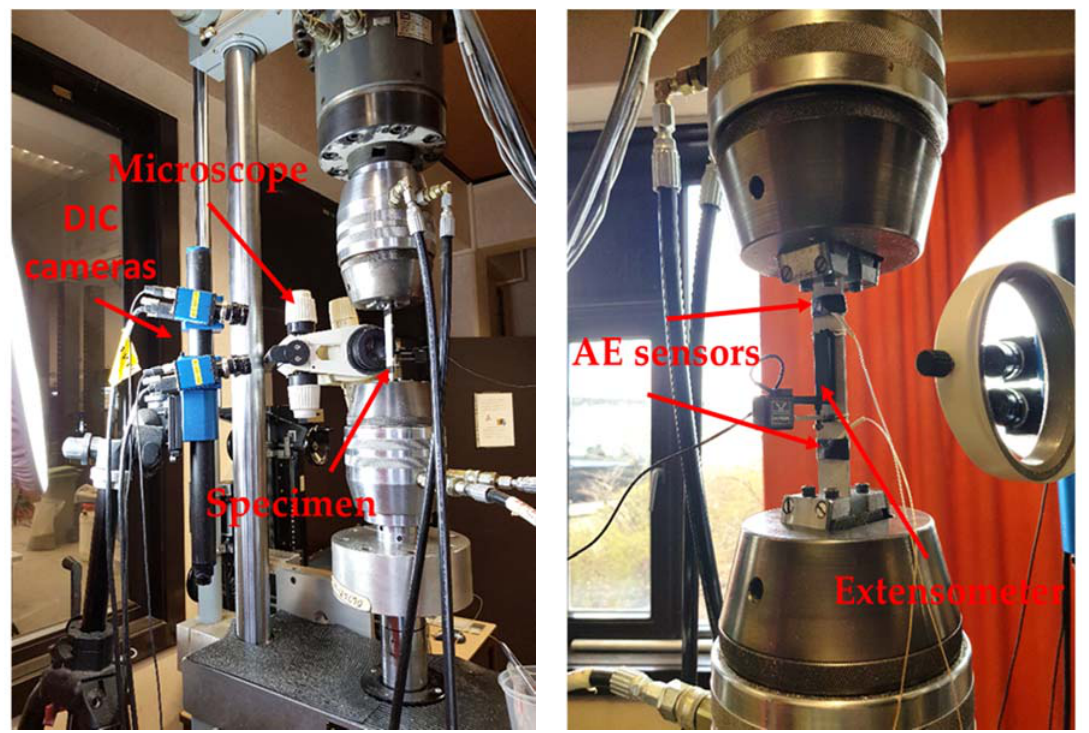
Figure 2. Experimental set-up. DIC—digital image correlation; AE—acoustic emission.